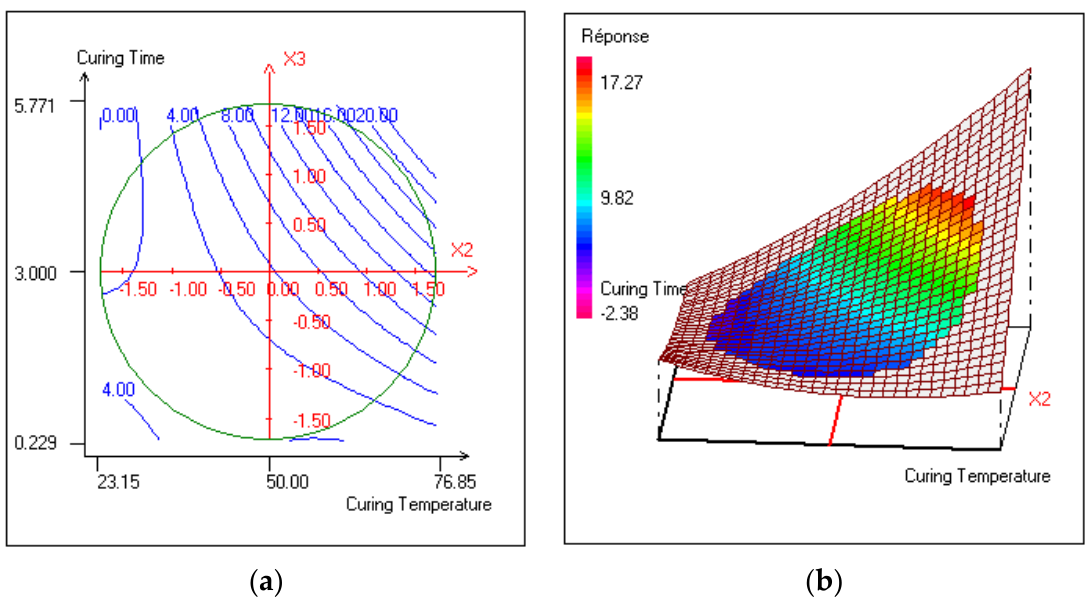
Figure 7. Variation in the response — released Al in the plan: curing temperature, curing time and fixed variable (P/Al molar ratio = 2.00): ( a ) 2D contour plot; ( b ) 3D curve plot.